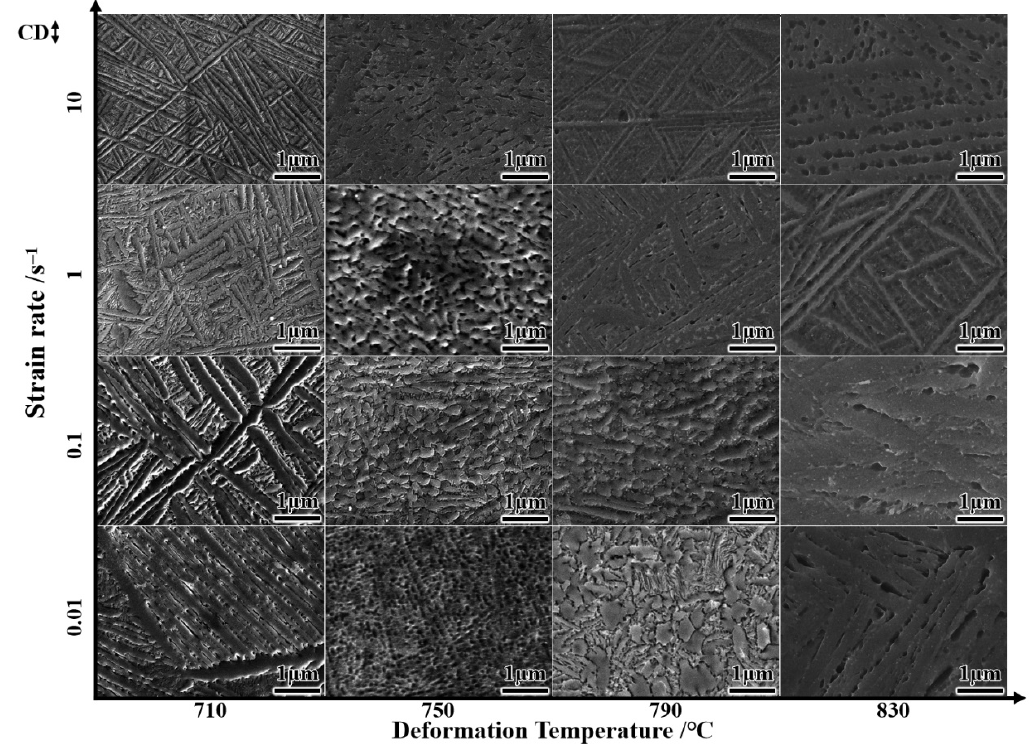
Figure 3. SEM observations of deformed Ti15Zr5Cu alloy under different conditions. CD represents compression direction.